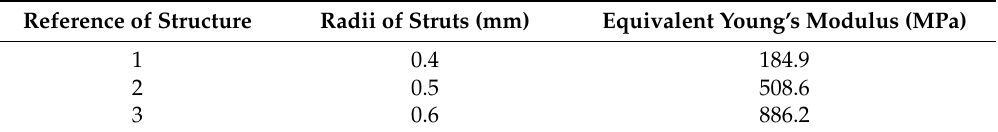
Table 6. Equivalent Young’s modulus obtained from the FEM.